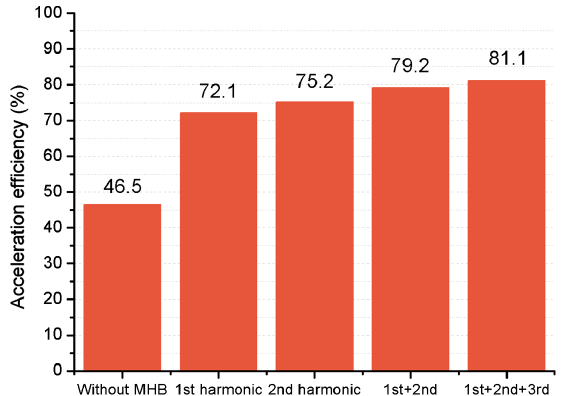
FIG. 27. Measured acceleration efficiencies of the RFQ for He 2 þ beam under different MHB operation